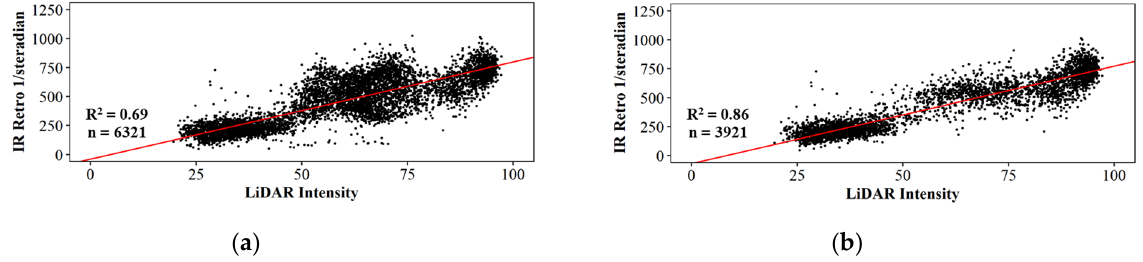
Figure 13. Right edge line linear correlation of LiDAR intensity and infrared retroreflectivity: ( a ) US-52 and US-41 combined linear correlation of LiDAR intensity and infrared retroreflectivity and ( b ) US-41 linear correlation of LiDAR intensity and infrared retroreflectivity.